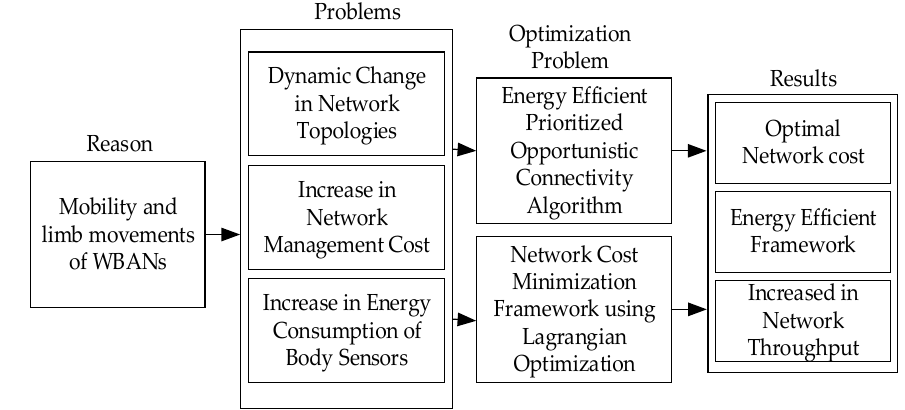
Figure 5. Overall framework of the NCMD protocol.